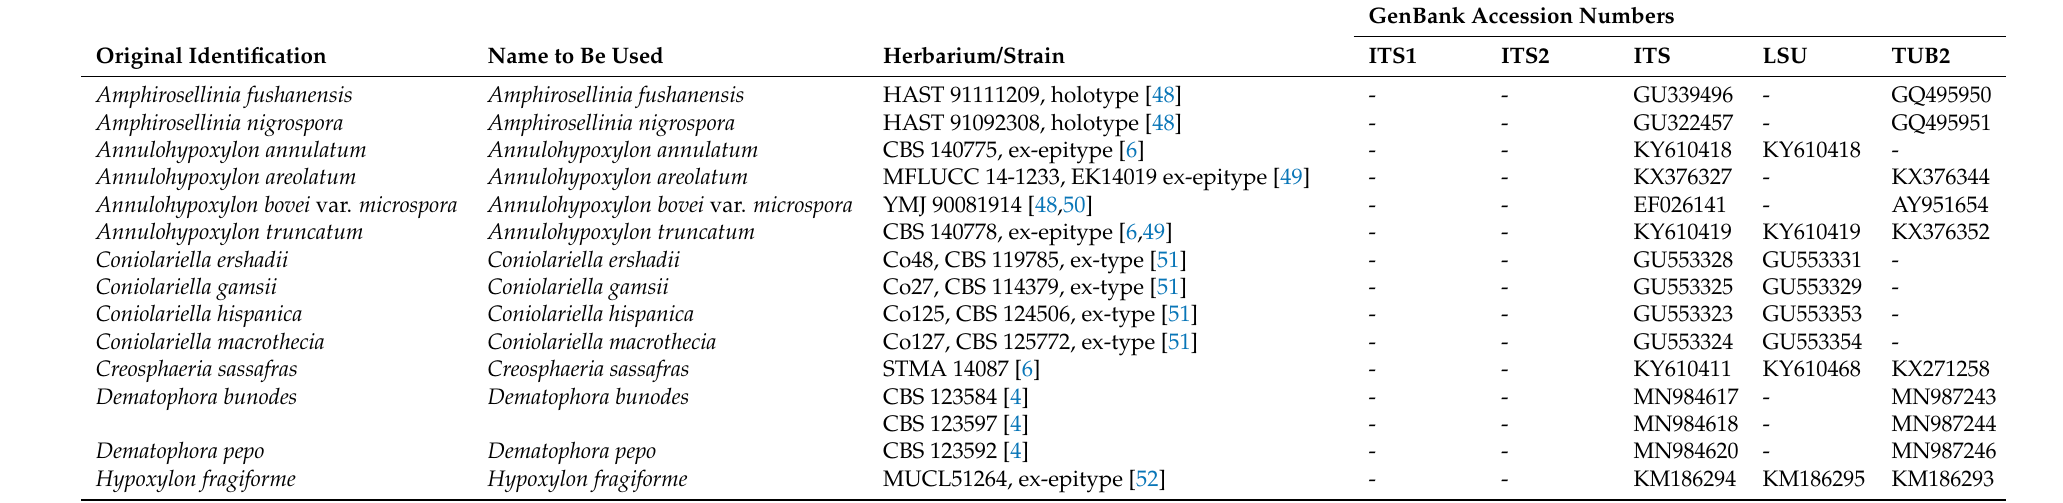
Table 2. List and details of Xylariaceae and Hypoxylaceae specimens used in the combined ITS-LSU-TUB2 phylogenetic analysis. Newly obtained sequences are reported in bold